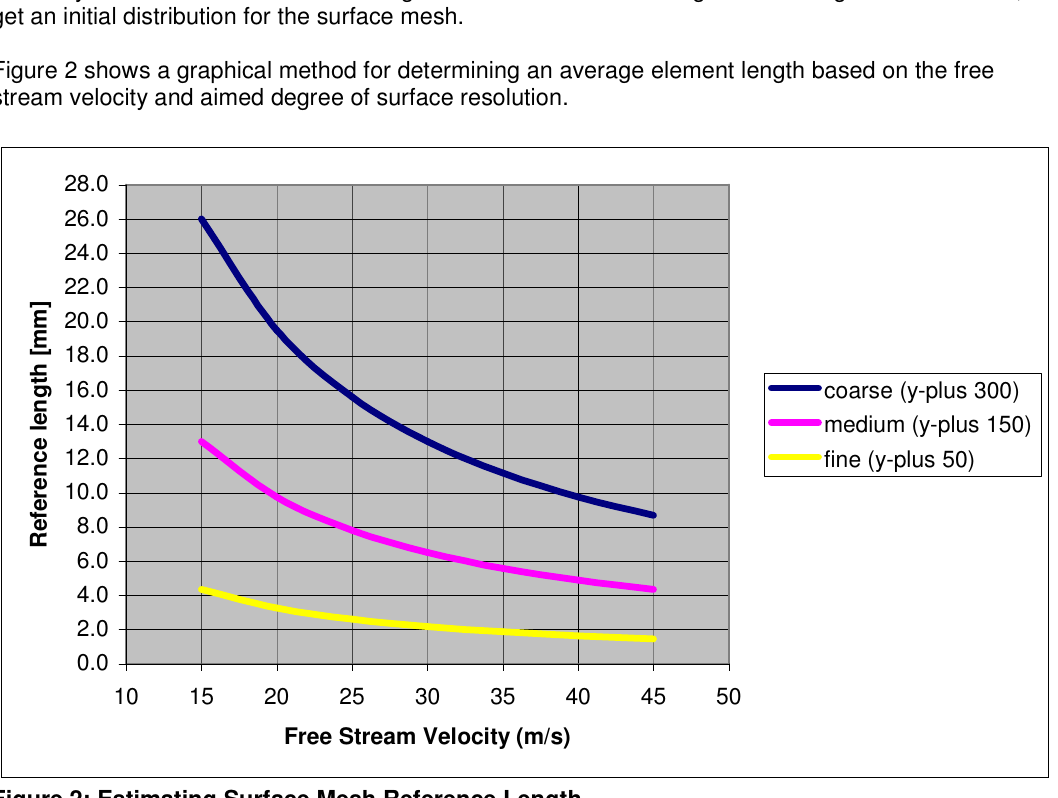
Figure 2: Estimating Surface Mesh Reference